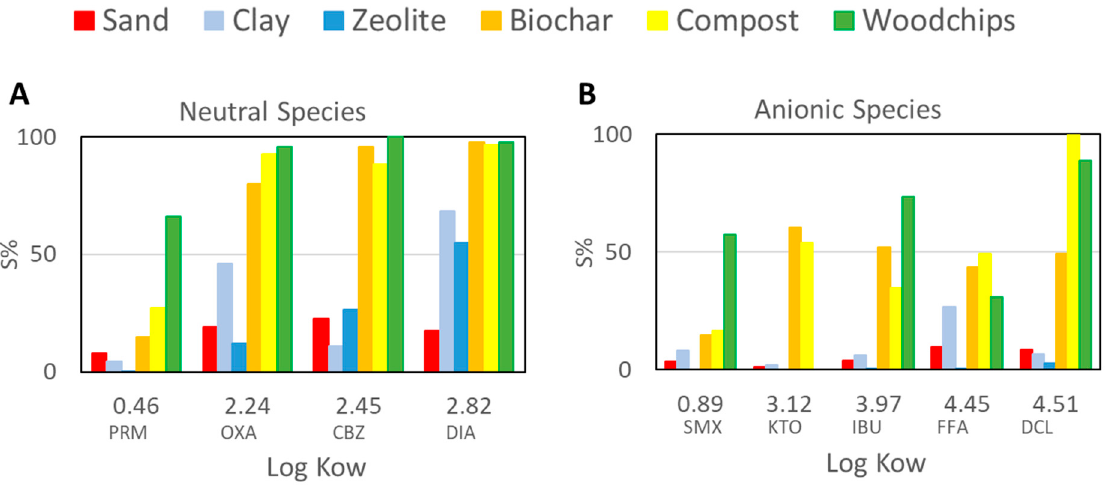
Figure 4. Sorption in sand (red), clay (pale blue), zeolite (dark Blue), biochar (orange), compost (yellow), and woodchips (green) of the neutral ( A ) and anionic species ( B ) versus their Log Kow .